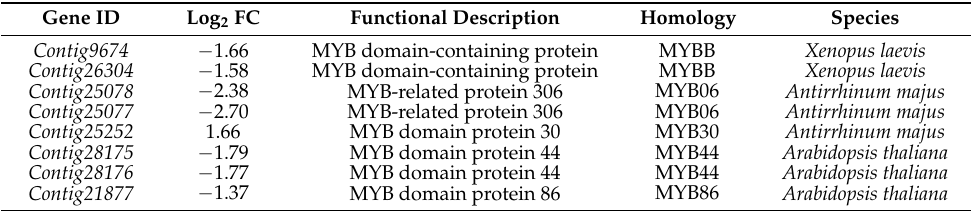
Table 3. MYB proteins regulated by heat stress in red